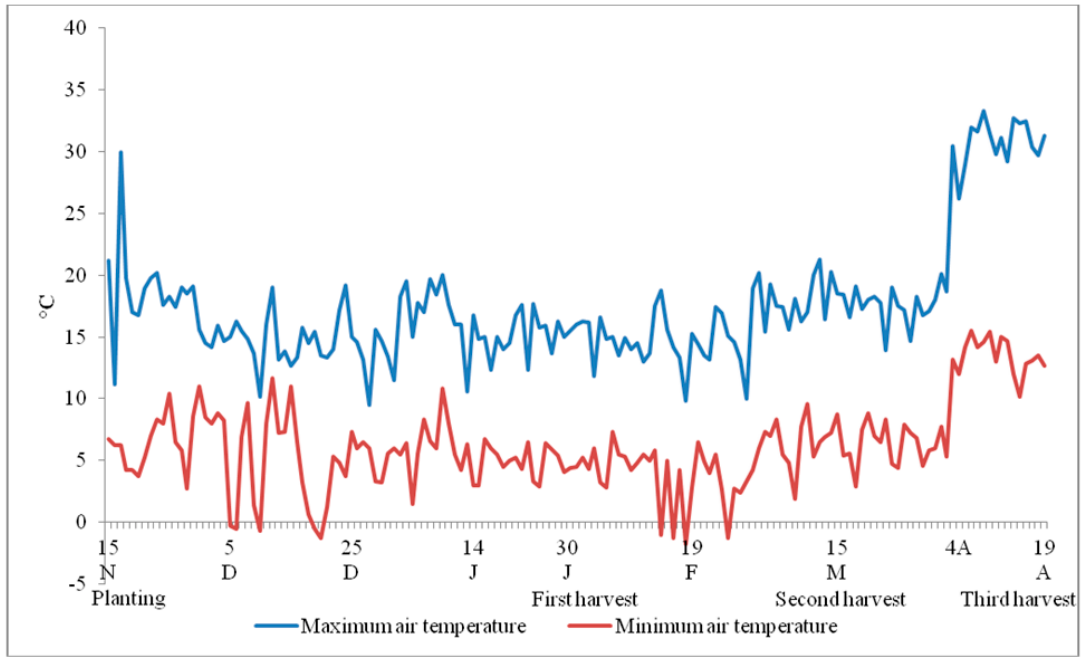
Figure 1. Trend of air temperature inside the greenhouse in Portici (Naples, southern Italy) as an average of 2016 – 2017 and 2017 – 2018.